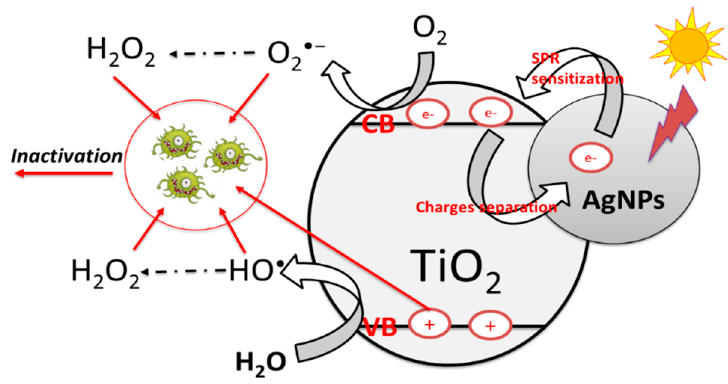
Figure 11. Plausible mechanistic pathways for the photocatalytic inactivation of E. coli on AgNPs–TiO 2 ceramic tiles. SPR, surface plasmon resonance.